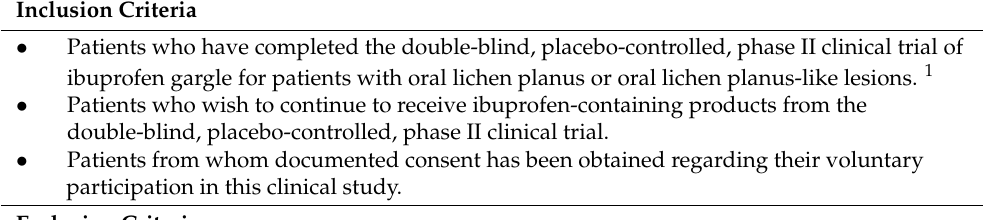
Table 2. Inclusion and exclusion criteria for the long-term extension